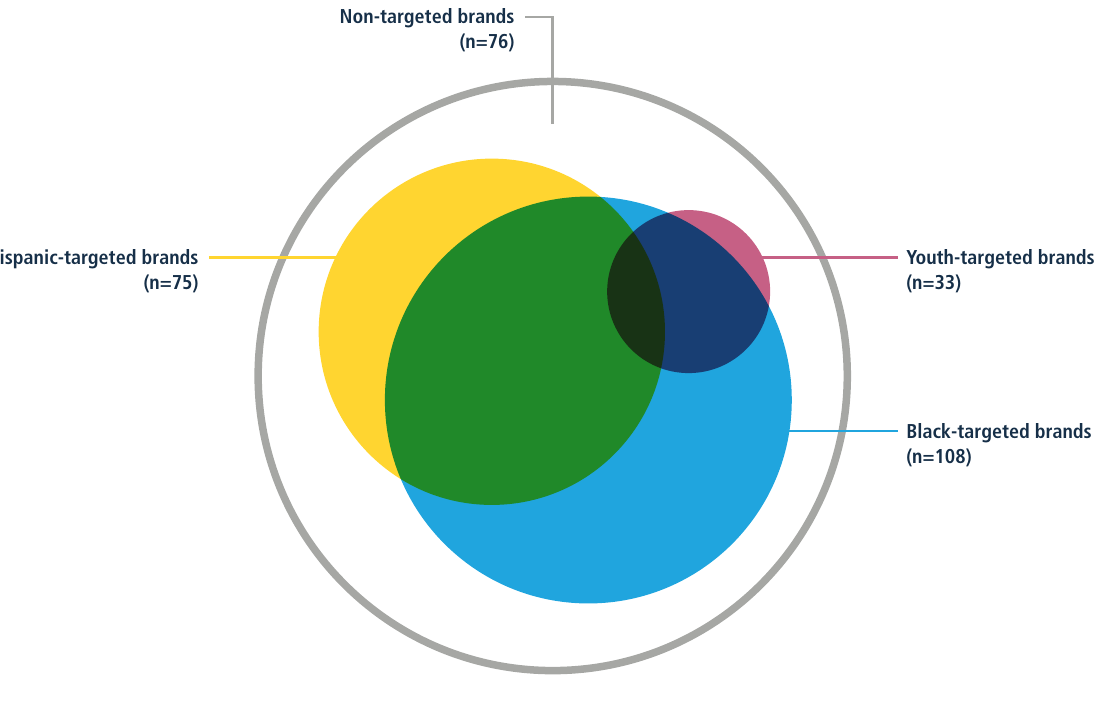
FIGURE 11. INTERSECTION BETWEEN YOUTH-, HISPANIC-, AND BLACK-TARGETED BRANDS